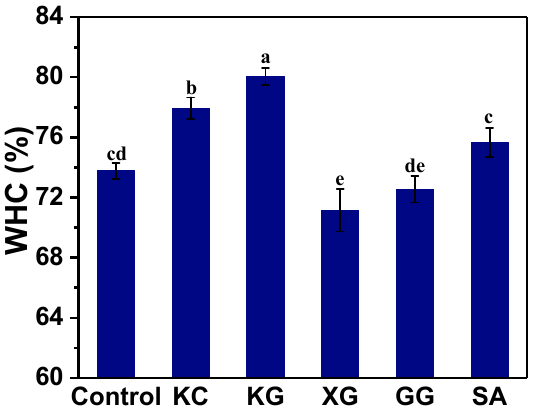
Figure 7. Water-holding capacity (WHC) of 3D-printed unwashed surimi gel after cooking. KC: κ -carrageenan; KG: konjac gum; XG: xanthan gum; GG: guar gum; SA: sodium alginate. Bars indicate the standard deviation (n = 5). Lowercase letters on the bars indicate significant differences ( p < 0.05).